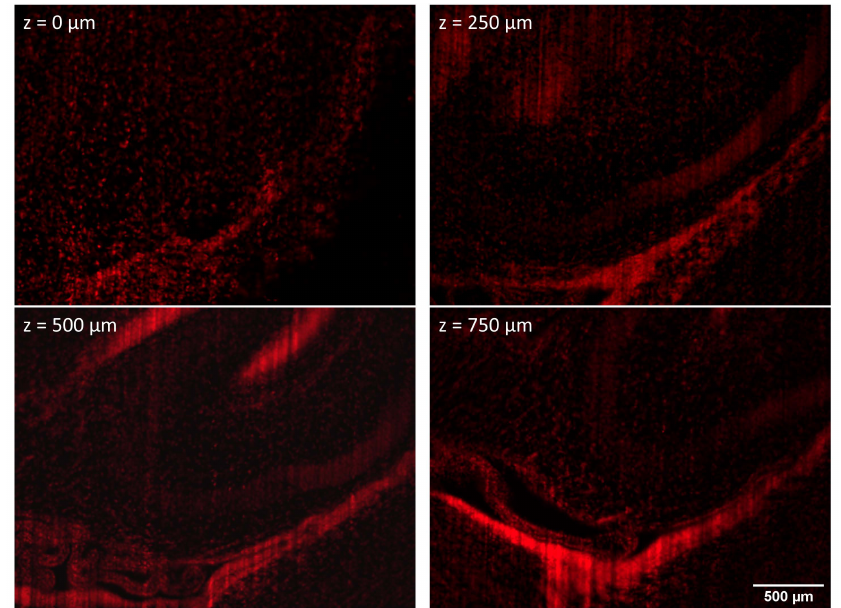
Figure 10. Light Sheet Fluorescence Microscopy of a 1 mm-thick mouse brain slice stained with Sytox Orange (DNA dye) and cleared with the Cubic clearing method [58]. A z-stack of 31 images with 50 µ m spacing was recorded. Representative images from the stack are depicted at depths of 0, 250, 500, and 750 µ m; scale bar: 500 µ m. Images recorded in cooperation with Marton Gelleri and Sandra Ritz, IMB Mainz.